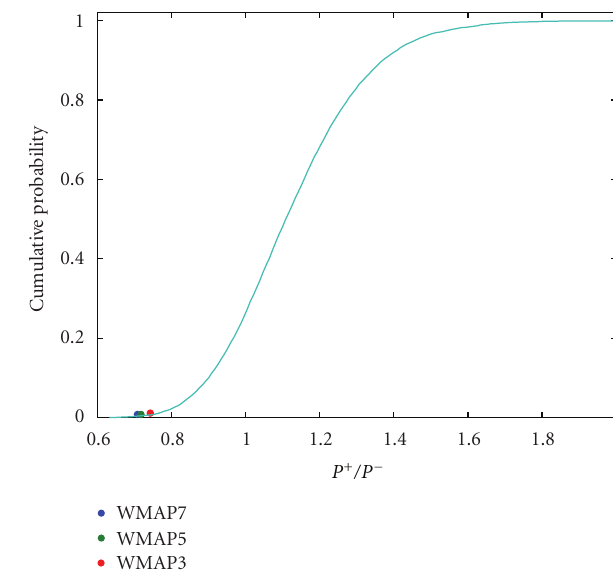
Figure 4: Probability of getting P + /P − as low as WMAP data for multipole range 2 ≤ l ≤ l max . Table 1: The parity asymmetry of WMAP data (2 ≤ l ≤ 22). Data